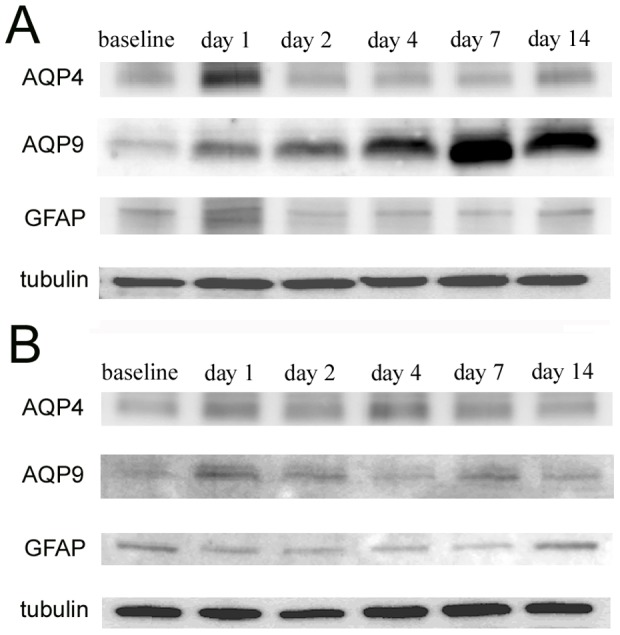
Representative western blots for aquaporin-4 (AQP4), aquaporin-9 (AQP9), and GFAP in extracts from the optic nerves after they were crushed (A) and sham (B) operated.Tubulin was used as an internal control.